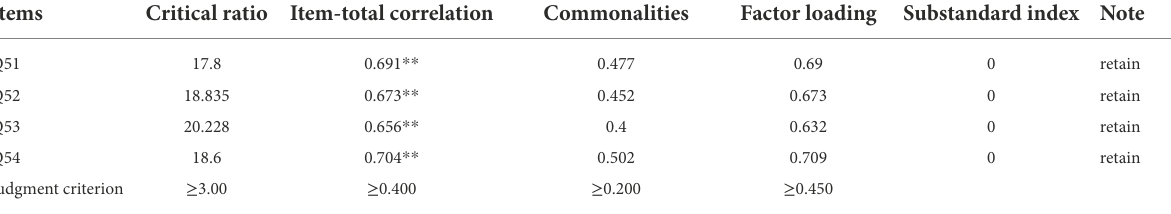
TABLE 2 Results of exploratory factor